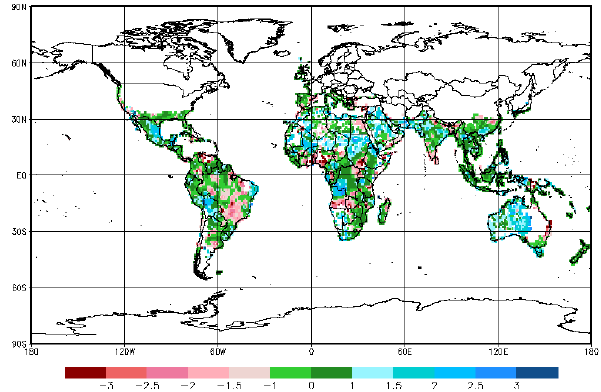
Figure 9. The SPEI with 6-month aggregation interval for Jan- uary 2014. The color scale is the same as in Fig.